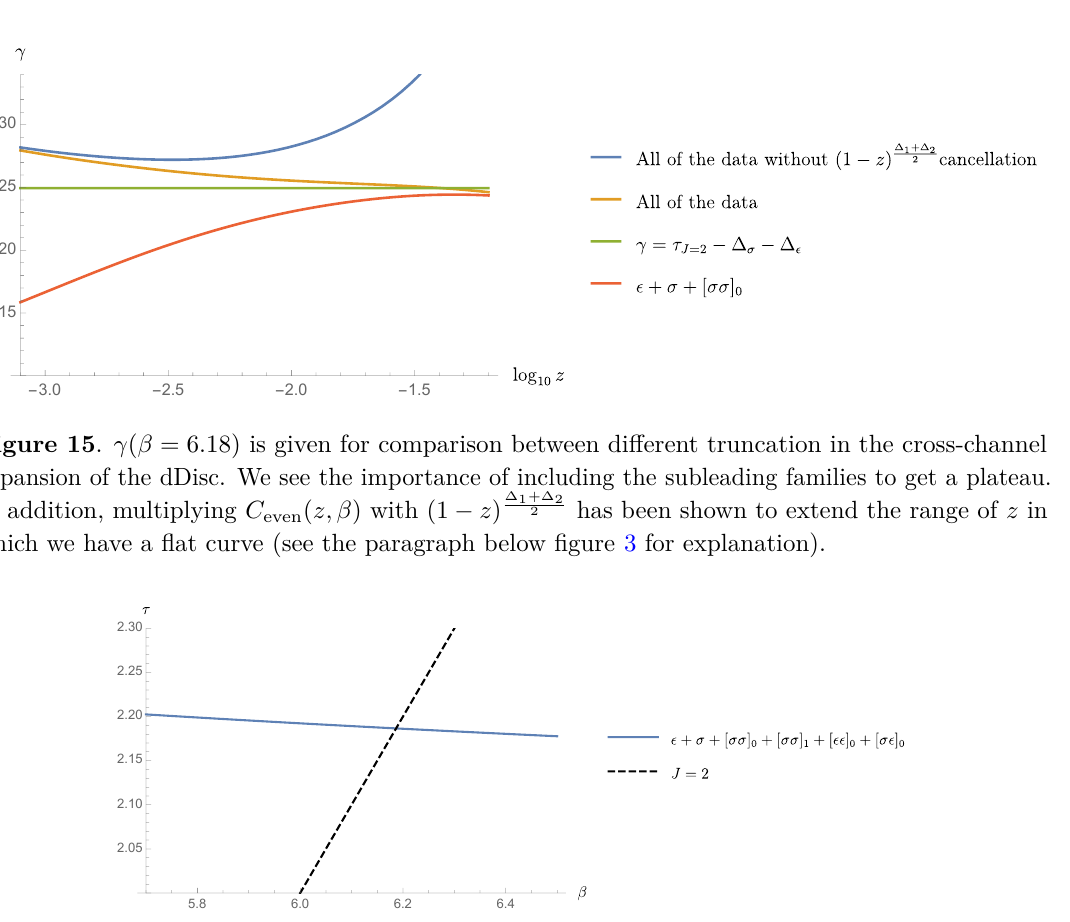
Figure 16 . The intersection point of the line J = 2 and the curve τ ( β ) is where the spin 2 operator is